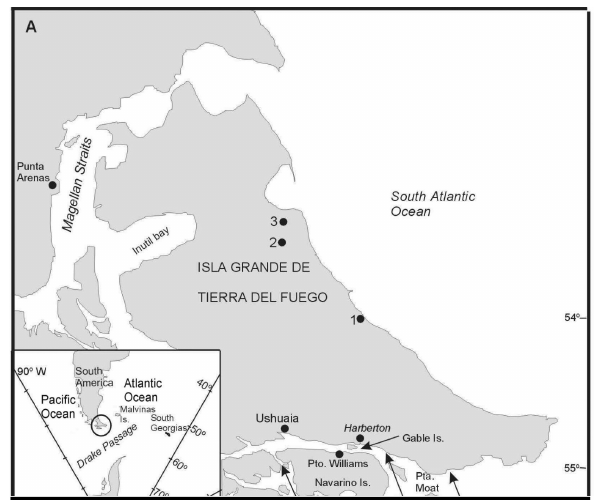
F IG . 1. – Map of Tierra del Fuego showing sites (A. labelled dots; B. black and white dots) with Quaternary molluscan faunas used for com- parison with the Antarctic. Black dots (B) indicate sites considered to evaluate changes in faunal composition after deglaciation: Lago Roca, Río Ovando, Bahía Golondrina and Río Varela. References: 1. San Pablo; 2. Río Chico; 3. La Sara (unpublished data)